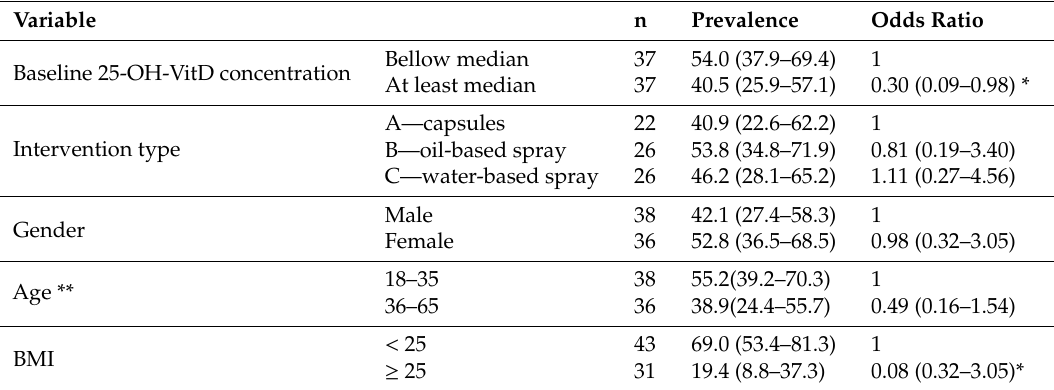
Figure 4. Serum 25-OH-VitD levels at baseline and after 8 weeks of vitamin D supplementation with three different vitamin D formulations in test groups in comparison to control group; *** p < 0.0001 for change from baseline within group; ns: not significant. Table 3. Prevalence of the above-mean increase in serum 25-OH-VitD level and adjusted odds ratios (95% CI) in subjects included to treatment groups (N = 74).